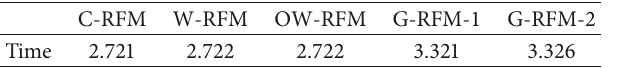
Table 3: Comparison of the running time of each algorithm.